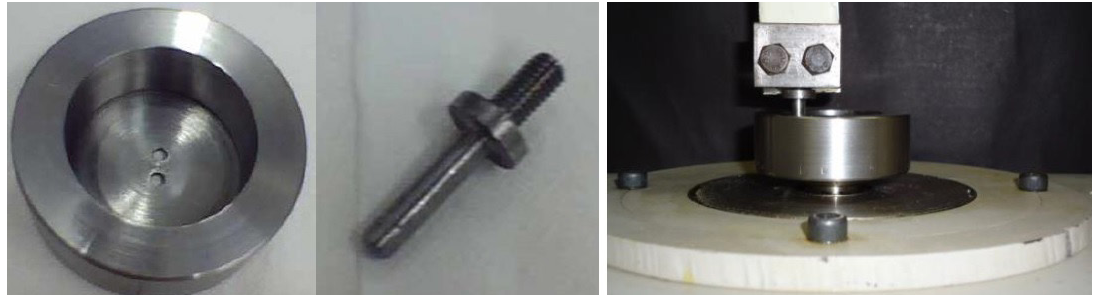
Figure 2. Cup-shaped disk made of SAE 8640 steel, SAE 4140 steel pin and apparatus assembly.